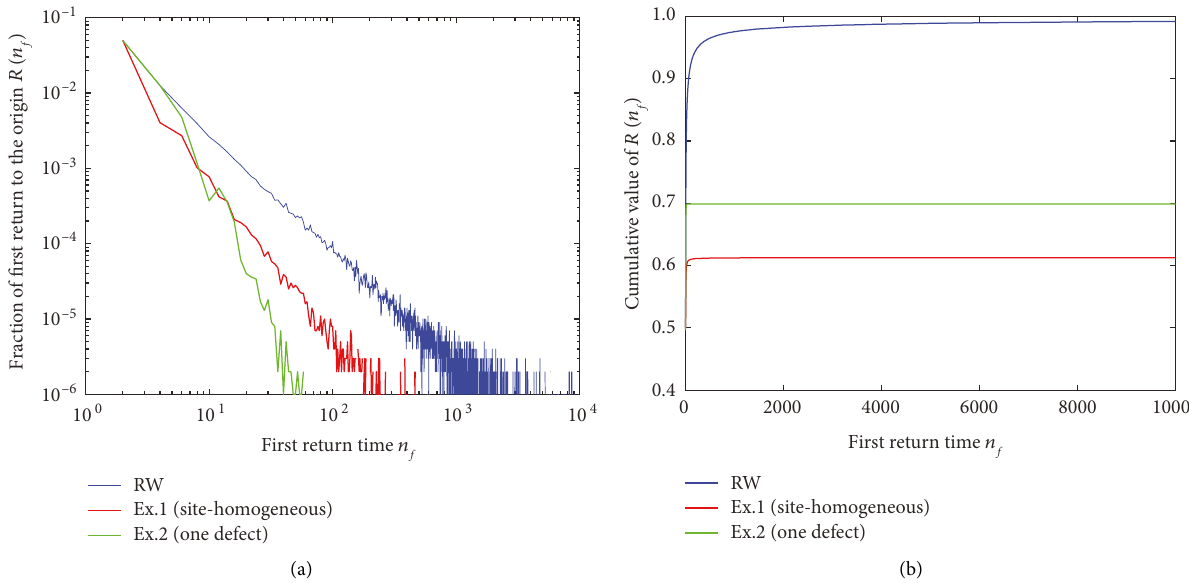
Figure 6: (a) Relationship between time n K � 100000). (b) Cumulative value of R ( n and one-defect QWRW, R ( 10000 ) is approximately 0.992, 0.613, and 0.699,